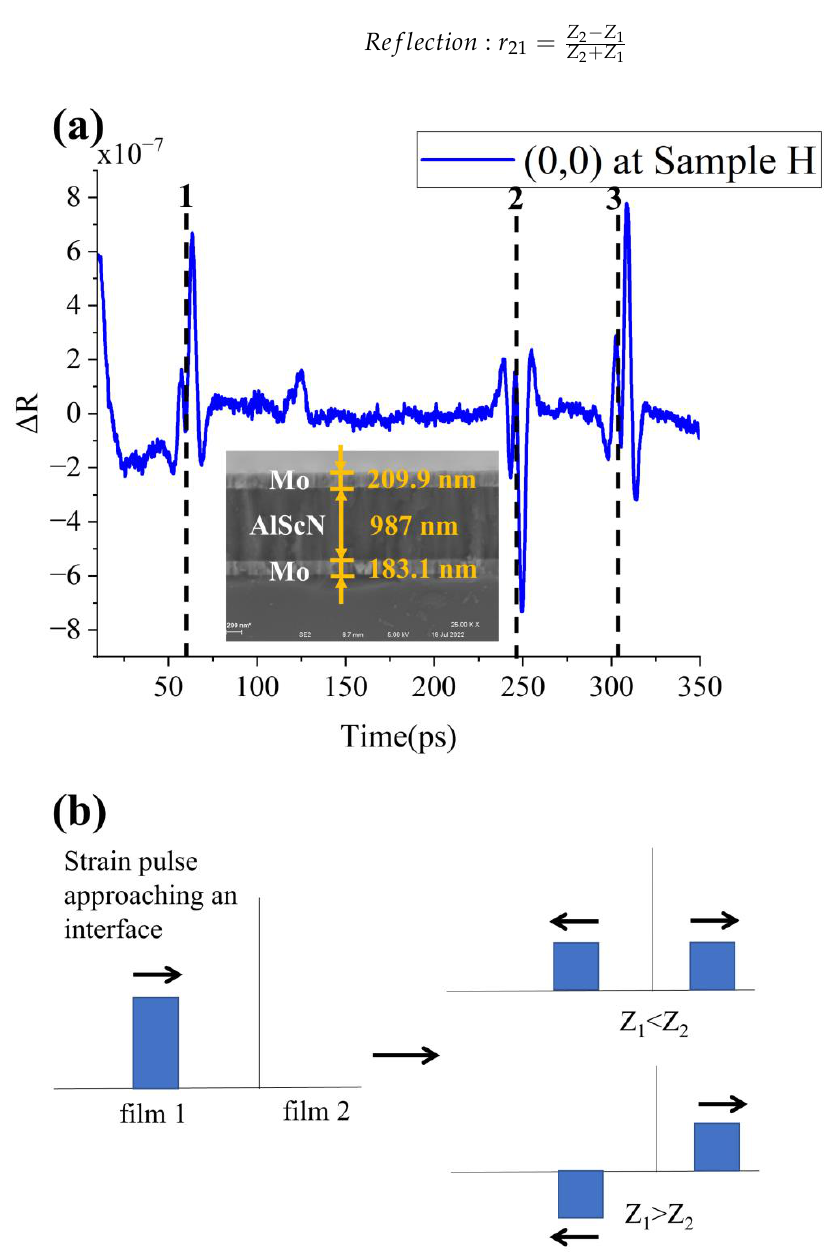
Figure 6. ( a ) Waveform diagram and SEM picture of sample G at (0,0) point. ( b ) Schematic of the strain reflection pulse.